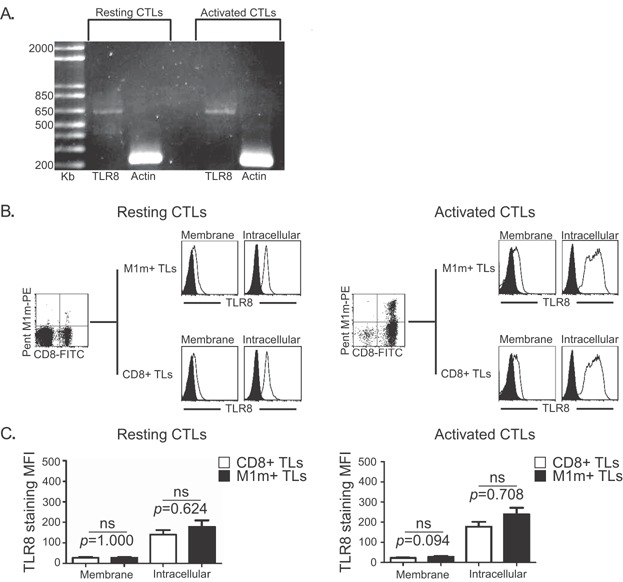
TLR8 expression by CD8+ T lymphocytes. A: Example of TLR8 expression analysis by RT-PCR with (Activated CTLs) or without (Resting CTLs) cell activation by anti-CD3 and IL-2. Actin was used as a positive control of the PCR reaction. The obtained bands are at the expected sizes. B,C: TLR8 expression was evaluated by flow cytometry with PE-conjugated anti-TLR8 antibody at the cell surface (Membrane) and in the intracellular compartment (Intracellular) of MART-1-derived A27L peptide (M1m)-specific T lymphocytes (M1m+ CTLs) and M1m-CD8+ TLs (CD8+ TLs), obtained before (Resting) and after co-culture (Activated) with M1m-expressing artificial APCs. B: Example of TLR8 expression of CD8+ TLs (lower profiles) and M1m+ TLs (upper profiles). White profiles: control isotype. Black profiles: specific staining. C: Mean fluorescence intensity (MFI) of TLR8 staining in CD8+ TLs (white bars) and M1m+ TLs (black bars) Data are represented with standard errors of means. These results have been obtained with six healthy donors, each donor having been studied in three independent co-culture experiments. Statistical tests (t tests) have been performed to compare both conditions. Non significant (ns): p > 0.05.